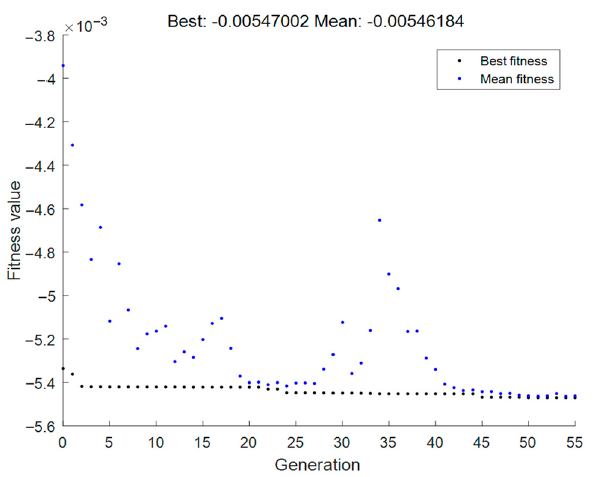
Figure 5. The optimization process of the orbital parameter design using the genetic algorithm.